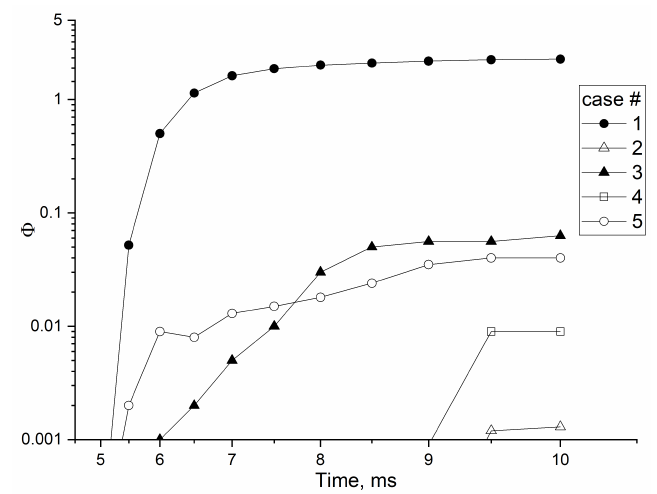
Figure 10. Average equivalence ratio in spark